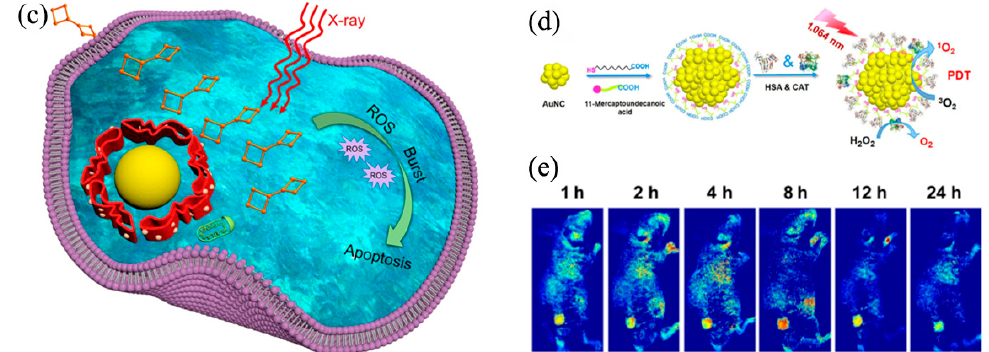
Figure 8. ( a ) Schematic illustration of D-Ag NCs damaging bacteria. Reprinted/adapted with permission from Ref. [77]. 2016, copyright American Chemical Society. ( b ) Influence model of surface properties of Au NCs on antibacterial activity. Reprinted/adapted with permission from Ref. [81]. 2018, copyright American Chemical Society. ( c ) Au 8 NCs for cancer radiotherapy via the ROS burst. Reprinted/adapted with permission from Ref. [86]. 2019, copyright American Chemical Society. ( d ) Mechanism model of prepare Au NC@HSA/CAT nanoparticles. ( e ) In vivo fluorescence images of tumor-bearing nude mice taken at different time points. Reprinted/adapted with permission from Ref. [88]. 2018, copyright Springer Nature.